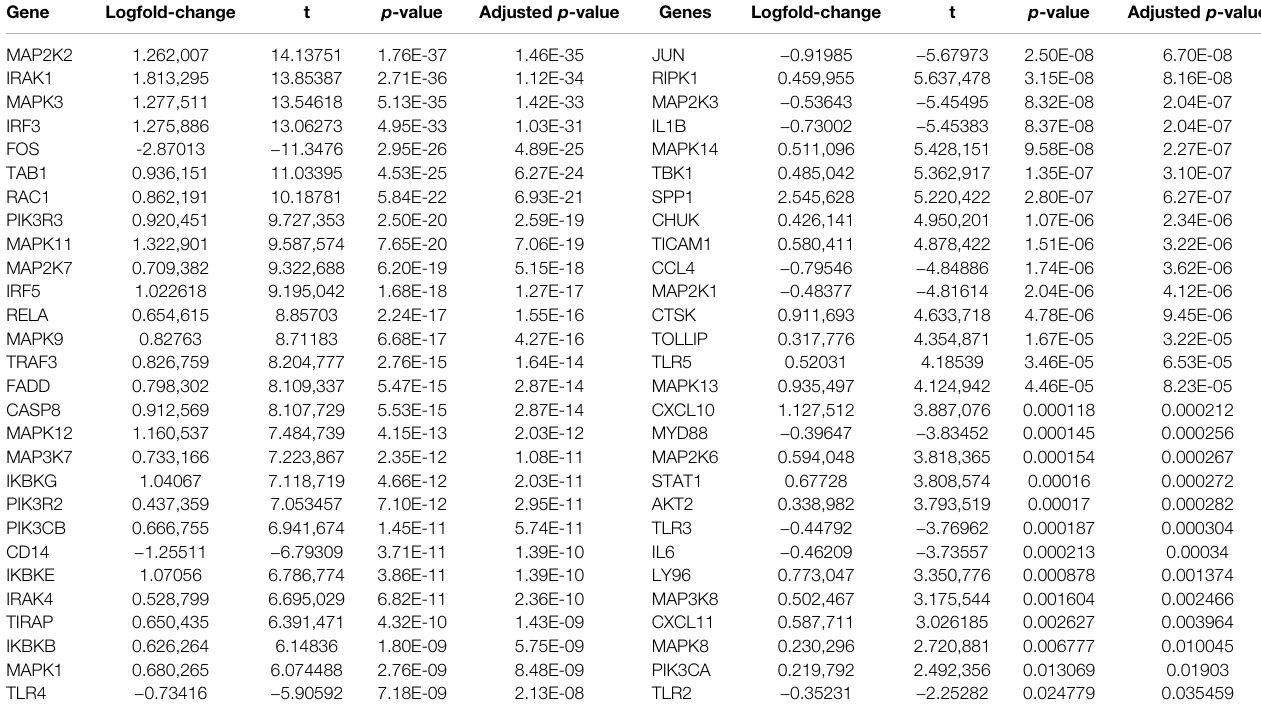
TABLE 1 | Identi fi cation of 60 HCC-speci fi c TLRs in the TCGA cohort. Gene Logfold-change t p -value Adjusted p -value Genes Logfold-change t p -value Adjusted p -value